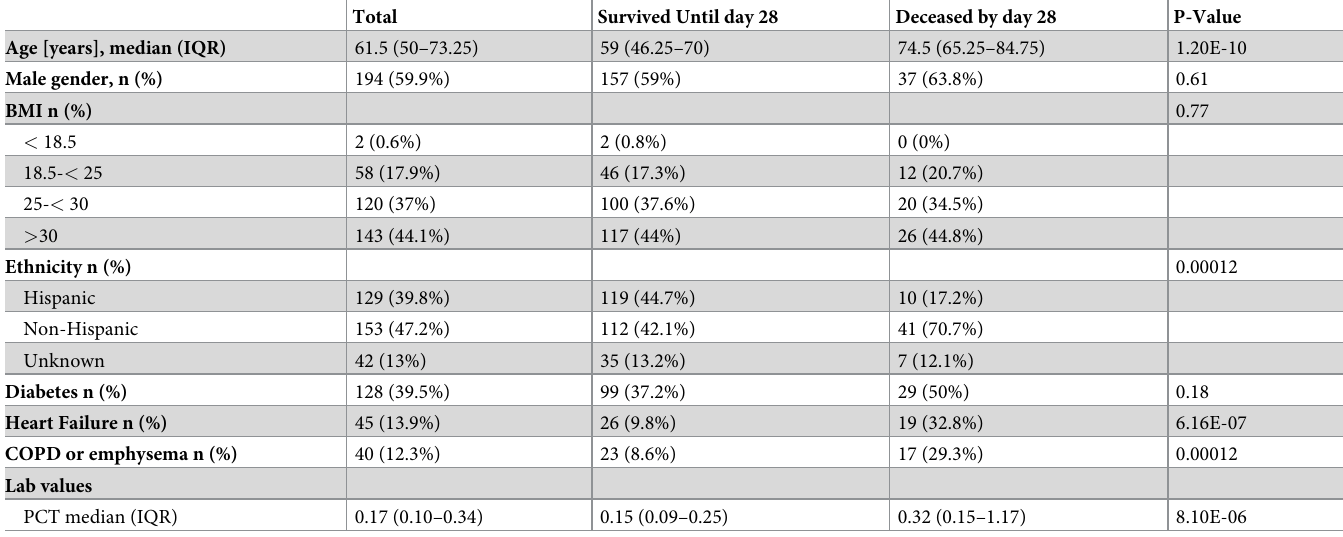
Table 1. Baseline patient characteristics.